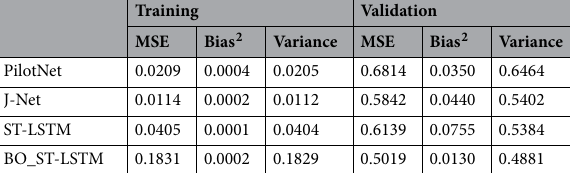
Table 4. Bias-variance tradeoff